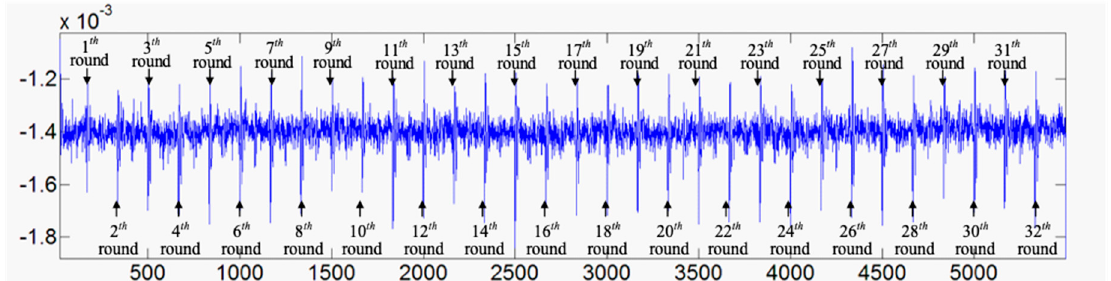
Figure 4. Simple power analysis curve and location of the encryption process.